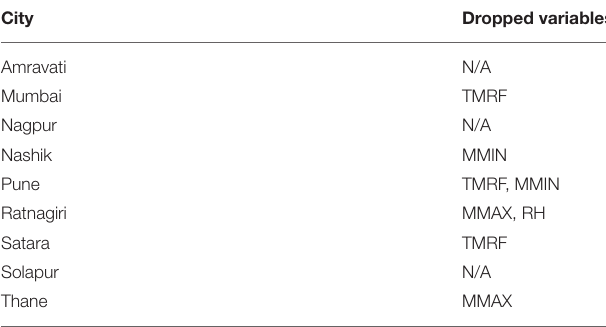
TABLE 2 | Dropped variables. City Dropped